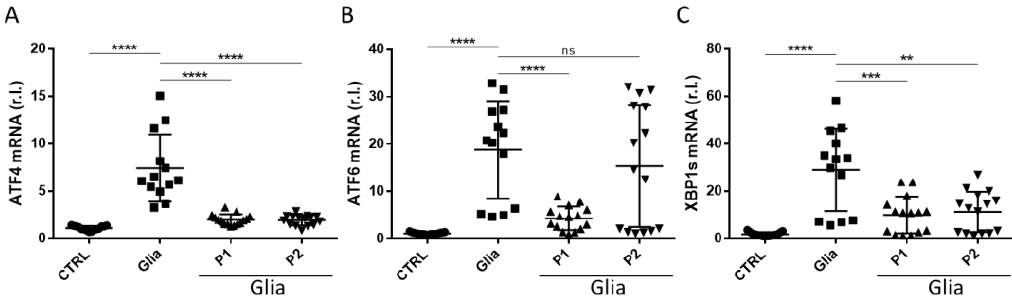
Figure 4. Endoplasmic reticulum (ER) Stress induced by gliadin exposure was buffered by probiotics. ATF4 ( A ), ATF6 ( B ), and XBP1s ( C ) expression levels were evaluated in the small intestine of Balb/c-fed third-generation gluten-free diet treated (Glia) on untreated (CTRL) with gliadin in the presence or absence of P1 or P2. Mean ± SD of triplicate sample; **** p < 0.0001; *** p < 0.001; ** p < 0.01; ns = not significant.